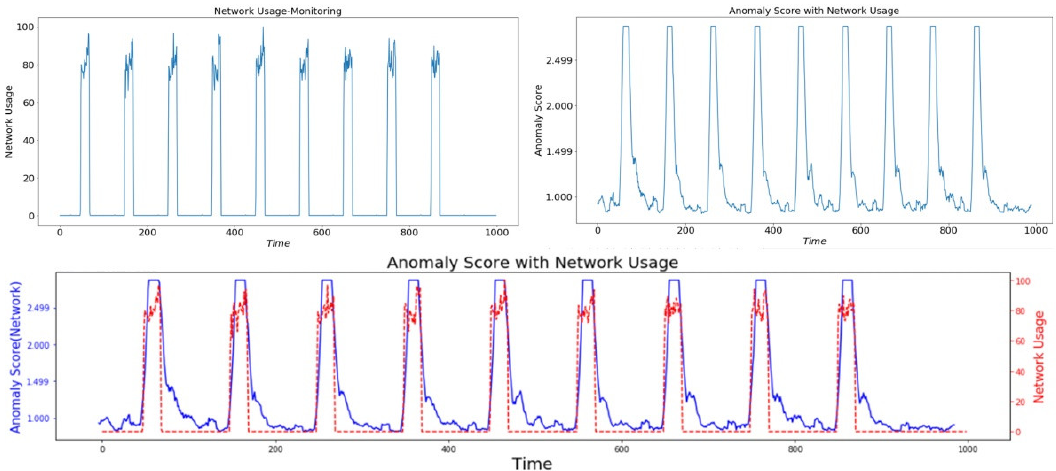
Figure 7. Anomaly Score (Network Fault).